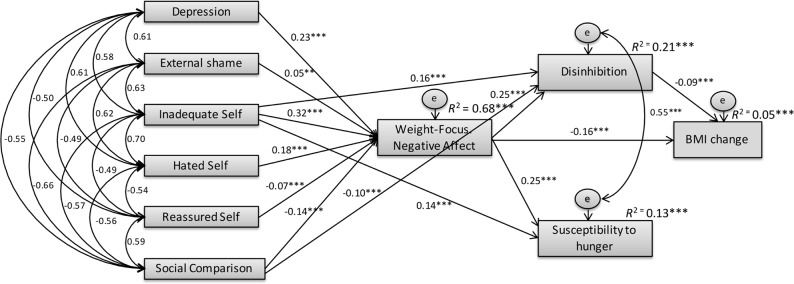
Path analysis for BMI changes.Mediation model with standardized estimates and R2 for weight-related negative affect, disinhibition, susceptibility to hunger and BMI changes. Model fit: χ2(16) = 75.970 (p < 0.001); CMIN/DF = 4.748; CFI = 0.994; TLI = 0.984; NFI = 0.993; RMSEA = 0.042, CI = 0.033 to 0.052, p = 0.897).